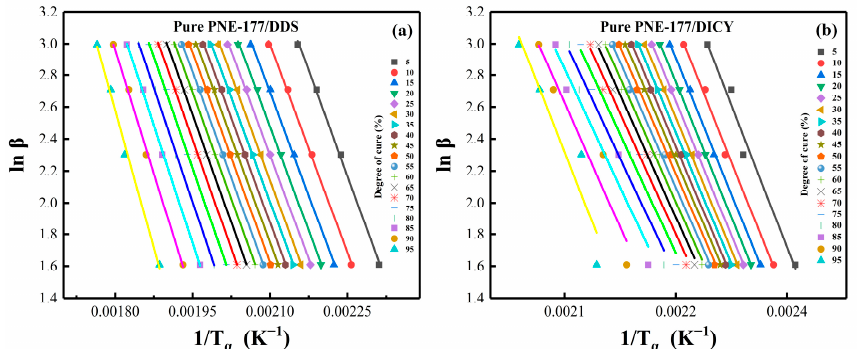
Figure 4. E a vs. α curves of different curing agent systems.